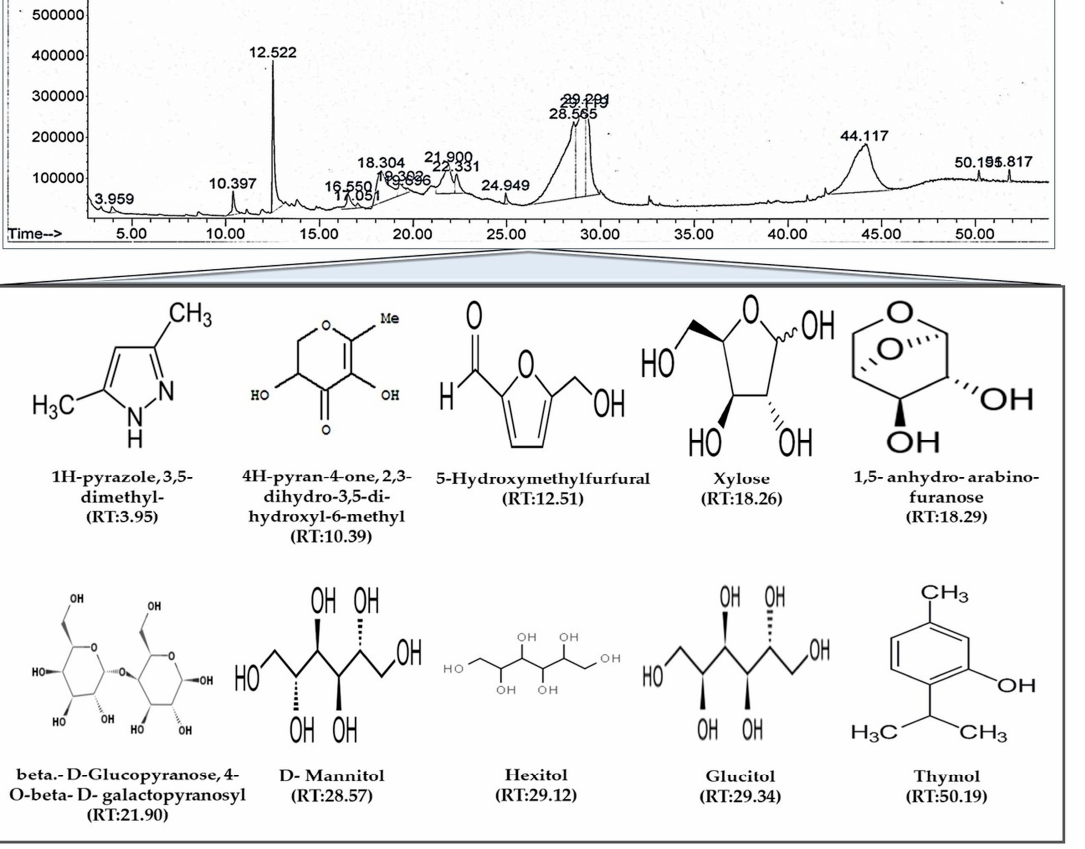
Figure 2. Gas chromatography mass spectroscopy (GC/MS) analysis of Pyrus ussuriensis Maxim ethanol (50%) extract. The chromatogram was obtained by GC/MS analysis of PUE. In the chromatogram, each peak represents a specific compound obtained at a unique retention time (RT). The lower part of the figure shows the chemical structures of some of the bioactive compounds along with their